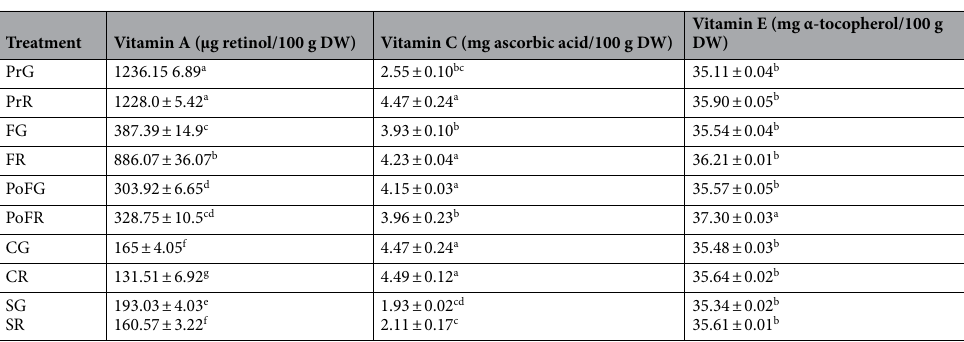
Table 5. Vitamins contents of samples of green and red roselle. Values shown are mean ± SD; different letters along a column represent significant differences at p < 0.05 among all the treatments. PrG pre-flowering green, PrR pre-flowering red, FG flowering green, FR flowering red, PoFG post-flowering green, PoFR post-flowering red, CG calyces green, CR calyces red, SG seed green, SR seed